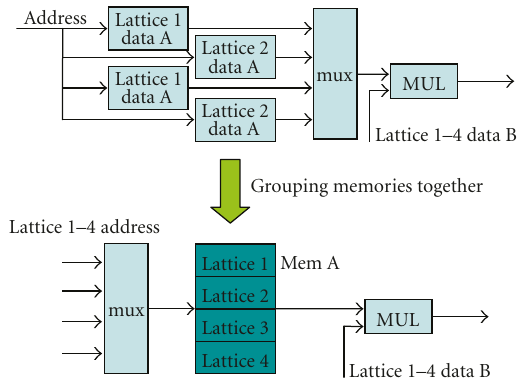
Figure 5: Reduction of multiplexers by grouping the block mem- ories.